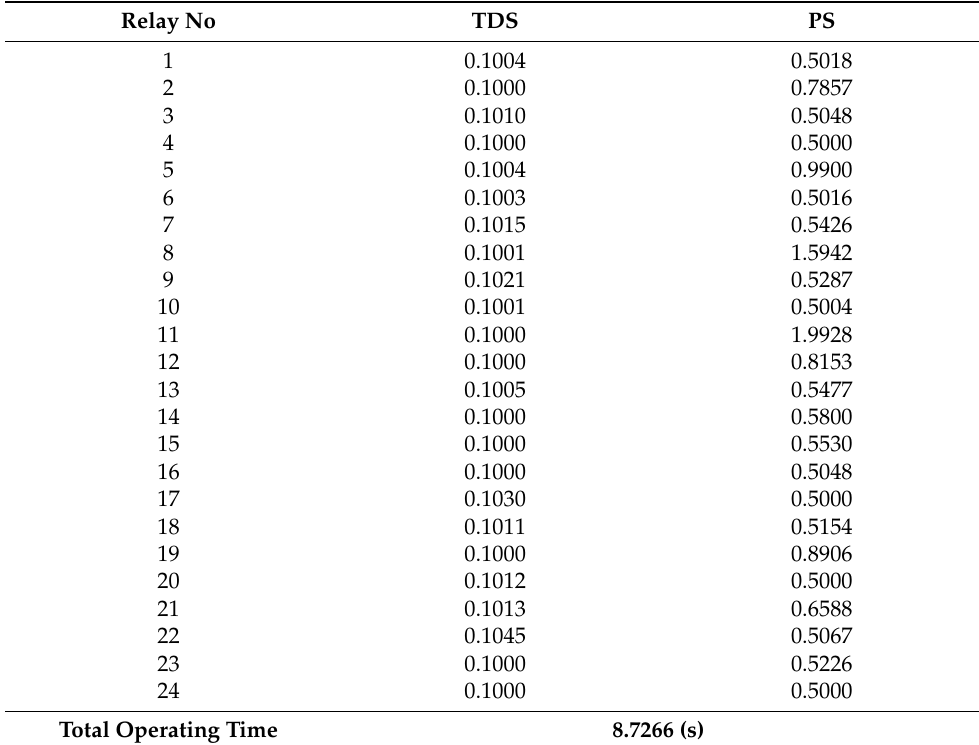
Table 2. Optimum value of TDS for the IEEE 9 bus system.